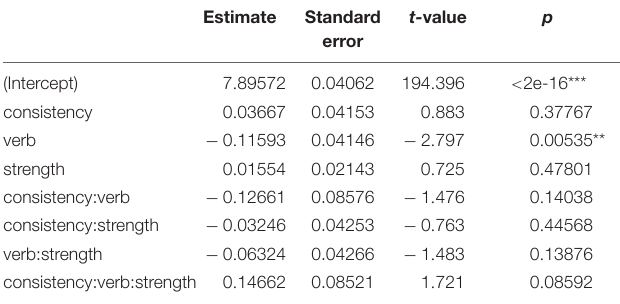
TABLE 6 | Model output of Experiment